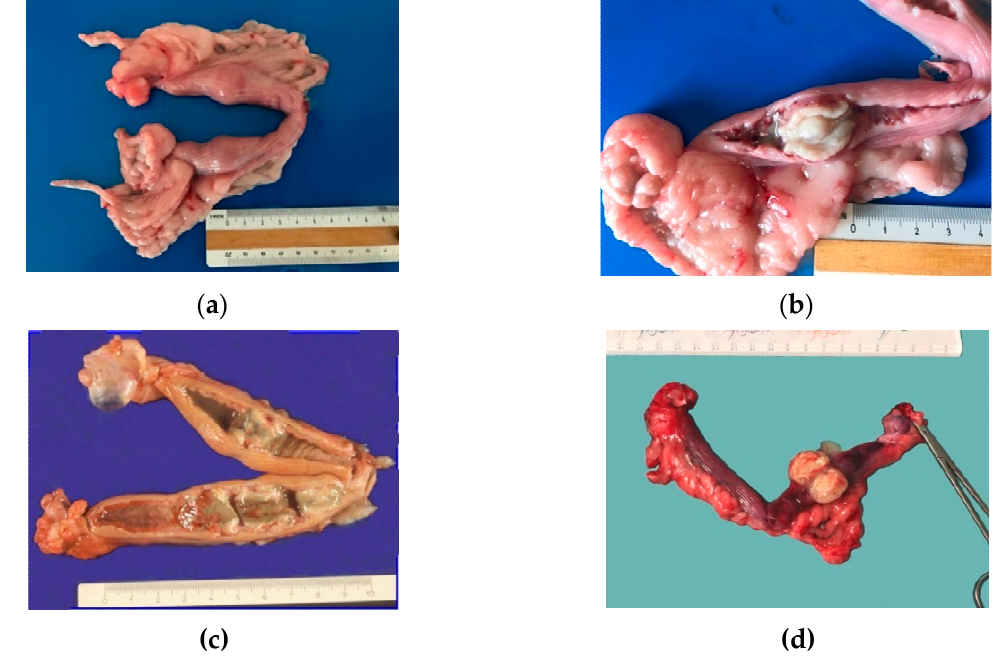
Figure 2. Gross findings in cases of pseudo-placentational endometrial hyperplasia: ( a ) the unopened uterus of case D1 with two spherical swellings; ( b ) the uterus of case D1 opened at the level of the swelling; the uterine mucosa is reddish; the lesion is almost white and seems leaned on the mucosa; ( c ) the genital tract of case D2 with four hyperplastic lesions which appeared greenish and accompanied by an abundant dirty fluid; ( d ) case D6 lesion with always the same size and appearance.